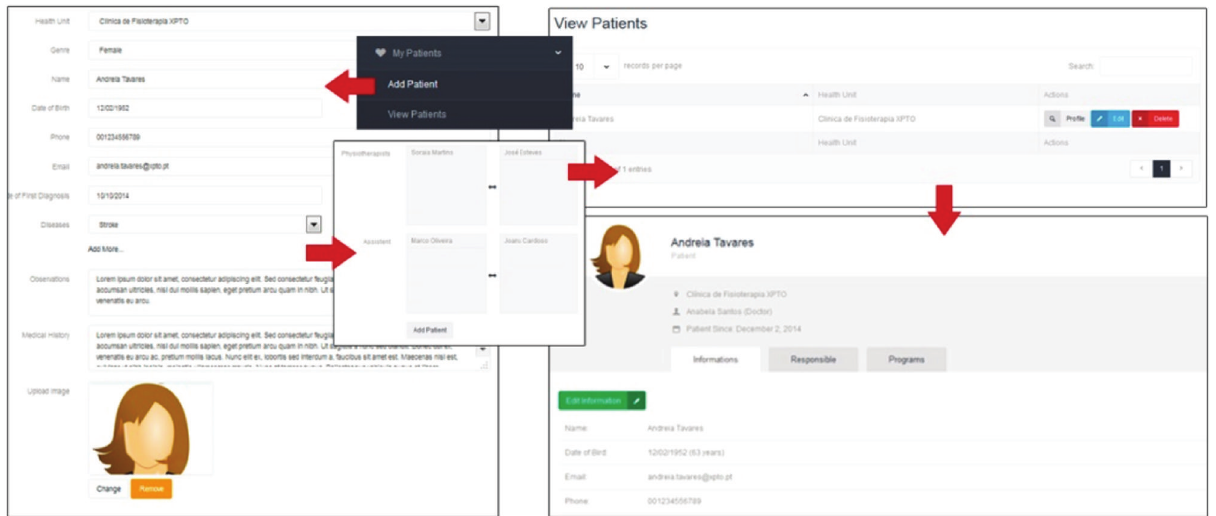
Figure 9: Creating process of a patient’s profile.